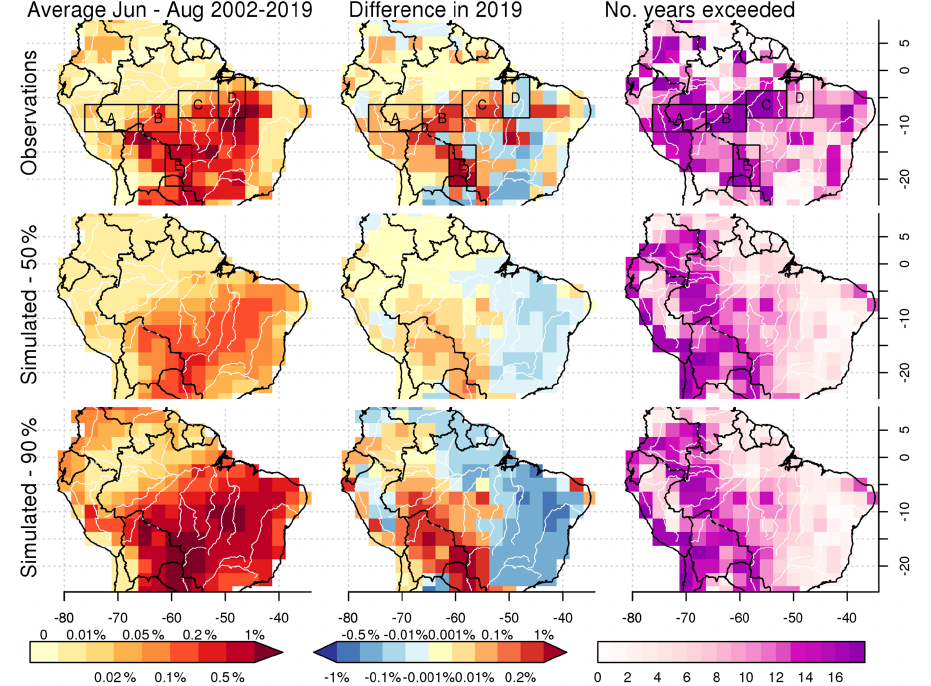
Figure 3. Maps of modelled and observed percentage of burnt area. First row: observed burnt area, for June–August 2002–2019 annual average (left) and difference between June–August 2019 and 2002–2019 average (centre) and the number of years which the 2019 burnt area exceeds (right). Second and third row: as top row, for the model posterior’s 5% and 95%